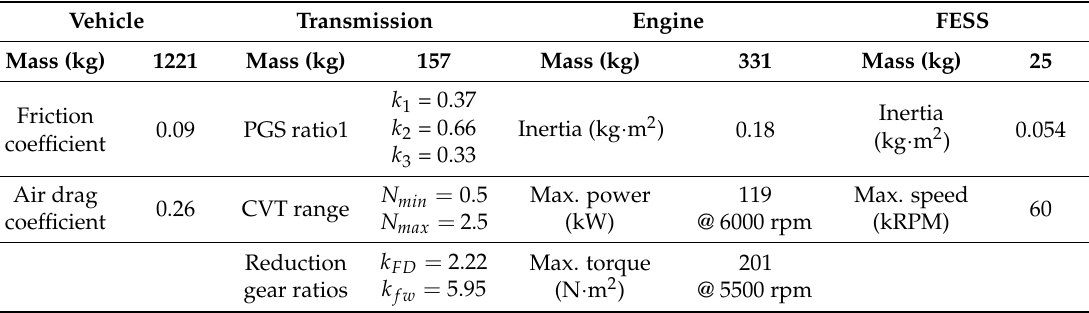
Table 2. The parameter setup for the PS-FHV